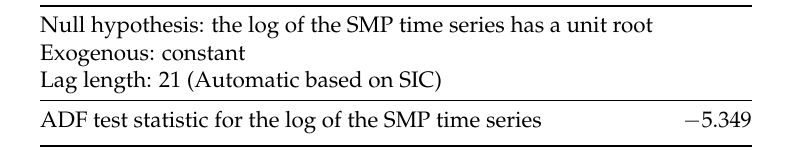
Table 4. The ADF test for the log of the SMP time